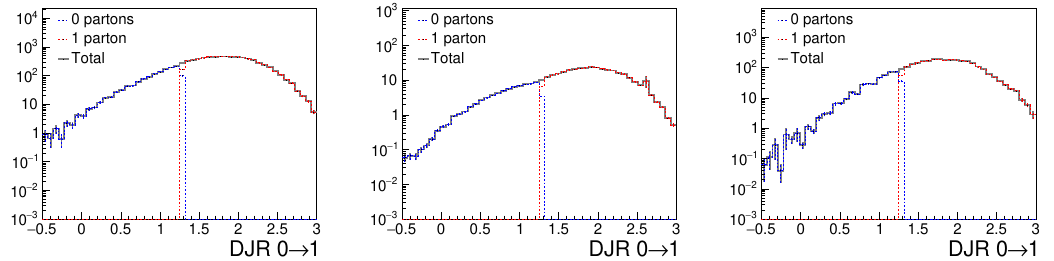
Figure 4 . DJR plots for xqcut = 10 , qCut = 19 for t¯th (left), t¯tW (middle) and t¯tZ (right). Here, all 9 Wilson coefficients considered in this study are set to non-SM values. The x axis shows the log base 10 of the scale at which an n jet event transitions into an n +1 jet event. The line labeled “0 partons” refers to the contribution from the parton shower, while the line labeled “1 parton” refers to the contribution from the matrix element. The line labeled “Total” is the sum of the two contributions.